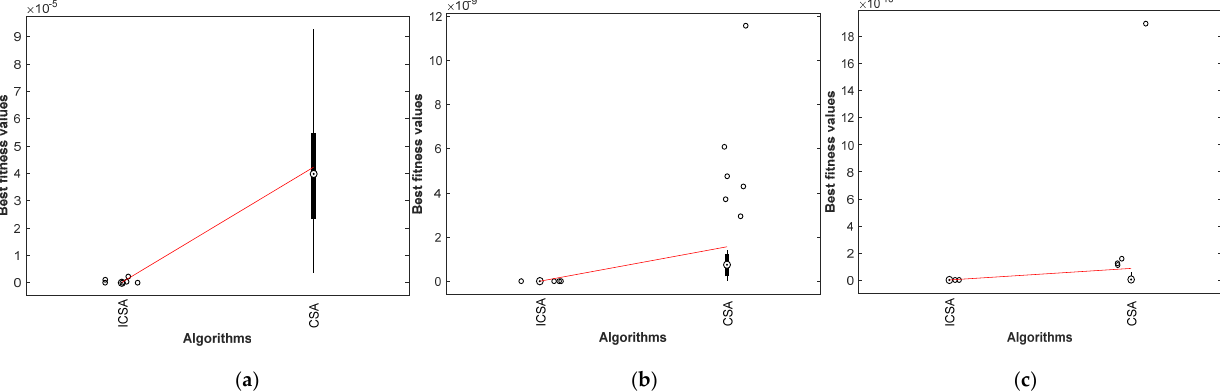
( c ) Figure 29. Boxplot of CSA and ICSA for various test cases : ( a ) Boxplot for F10; ( b ) Boxplot for F11; ( c ) Boxplot for F12.